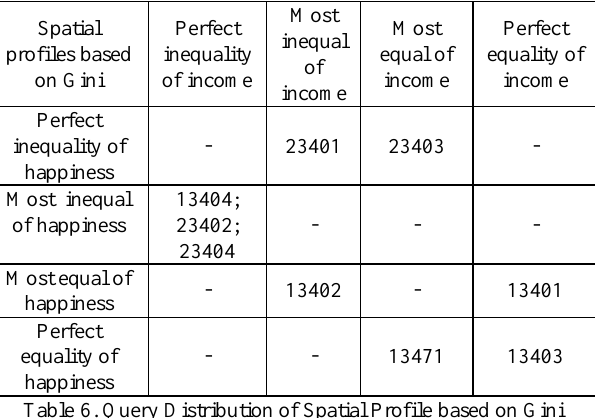
Figure 9. Poverty and Happiness Map of DIY Province based